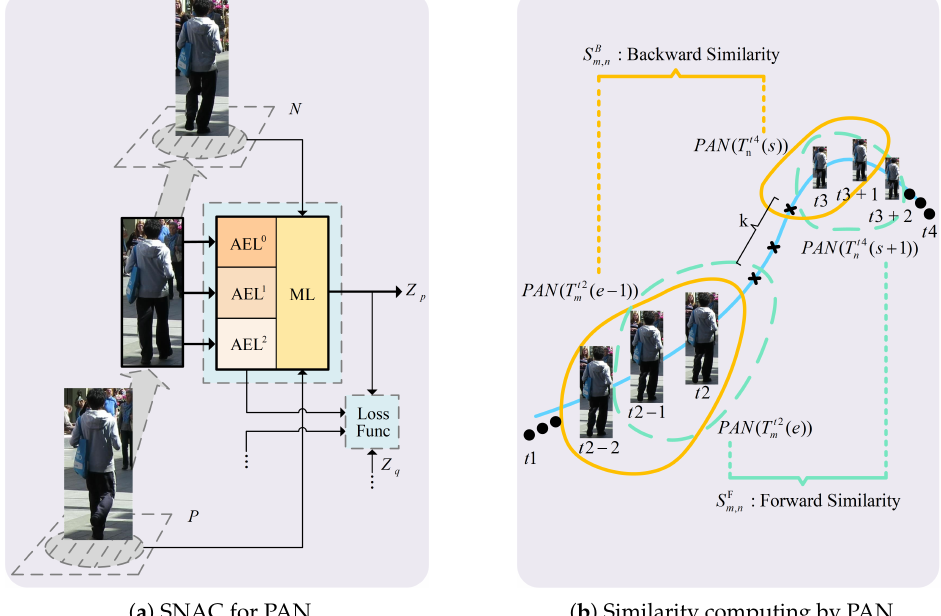
Figure 4. The generation and application of PAN. ( a ) SNAC is revised and added two pieces of motion information of a tracklet member together with the appearance codes from the auto-encoder layer as the inputs of the code-mix layer. During the online training process, the PAN feature is the final output of the code-mix layer. ( b ) Similarities of tracklets are determined by calculating the forward and backward PAN